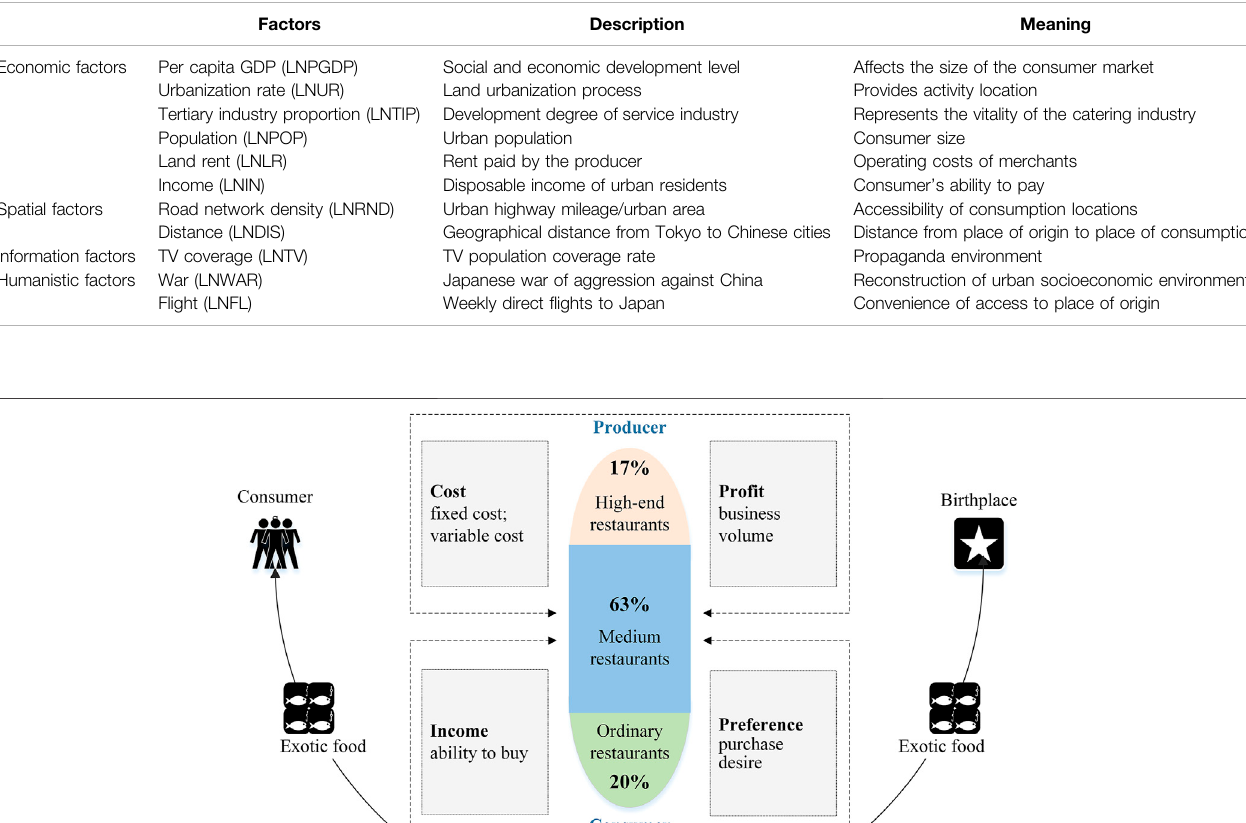
TABLE 1 | Socioeconomic factors and descriptions.